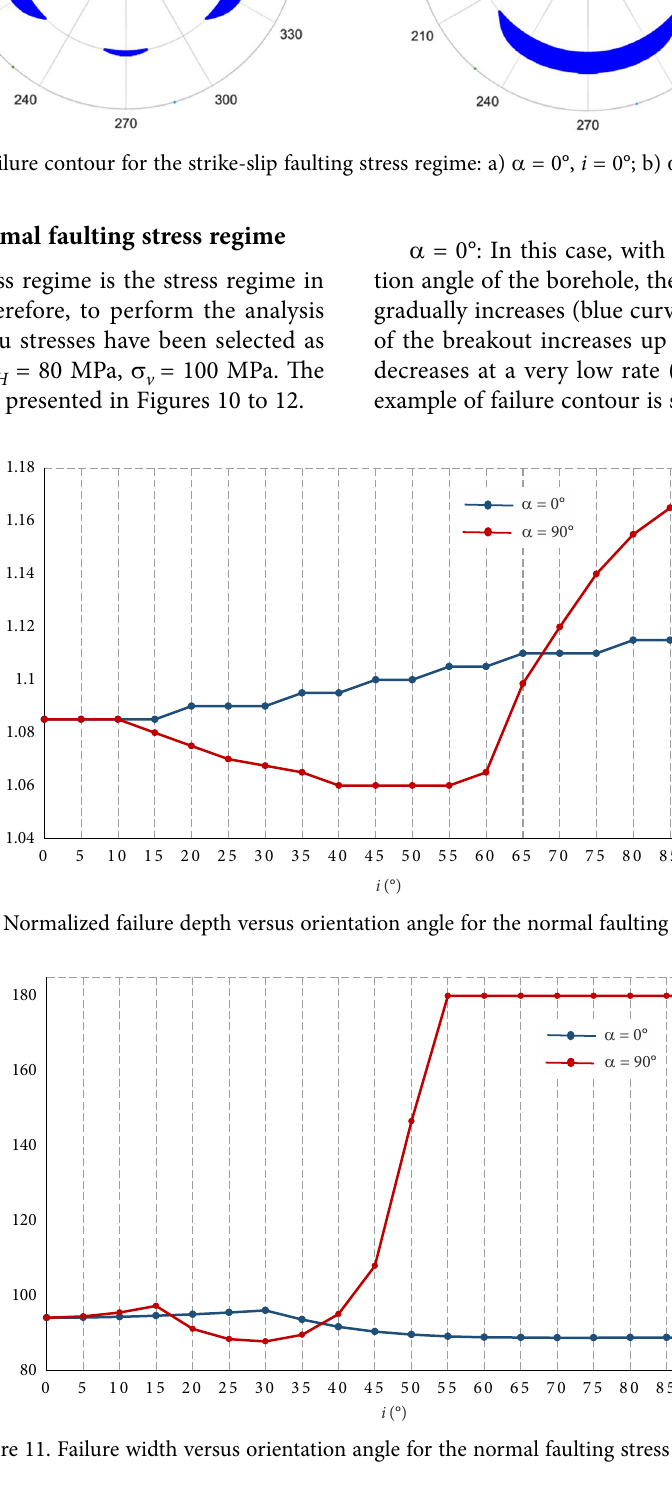
Figure 11. Failure width versus orientation angle for the normal faulting stress